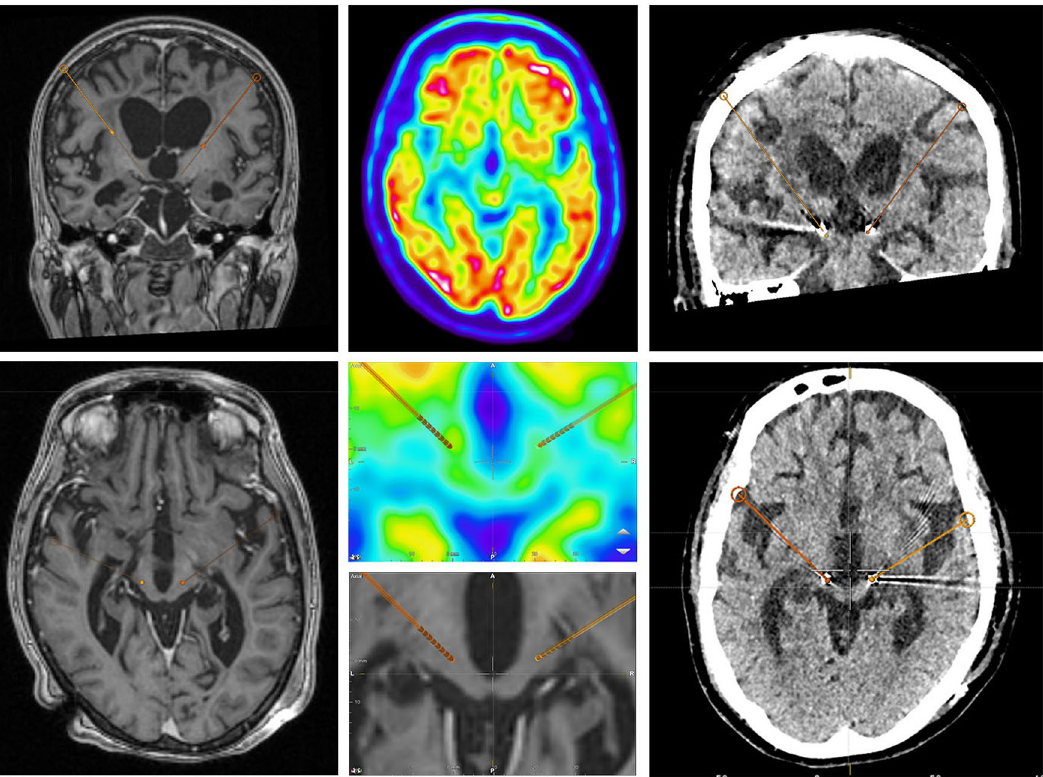
Figure 4. Left panel: intra-operative planning MRI with trajectories. Middle panel: 18 F-FDG PET-scan of target areas, including planned trajectories. Right panel: post-operative CT-scan with electrode